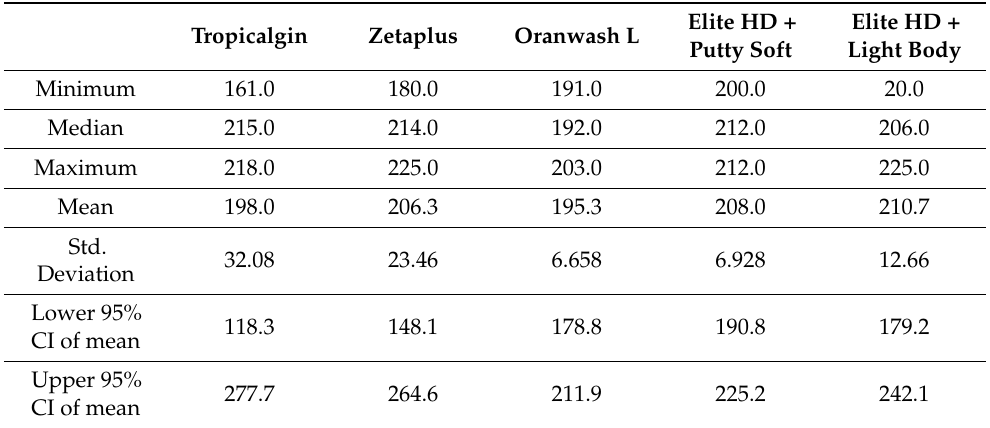
Table 4. The mean values of microbial colonies in the case of the control group for each impression material at 1:10 dilution.